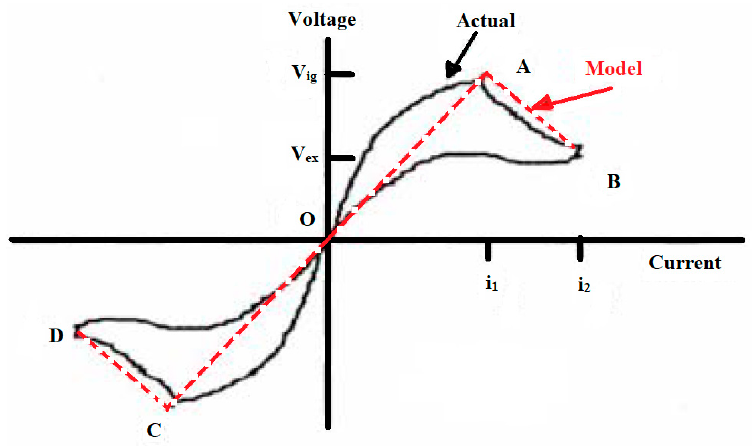
Figure 5. VIC-Actual and piecewise linear approximation model.